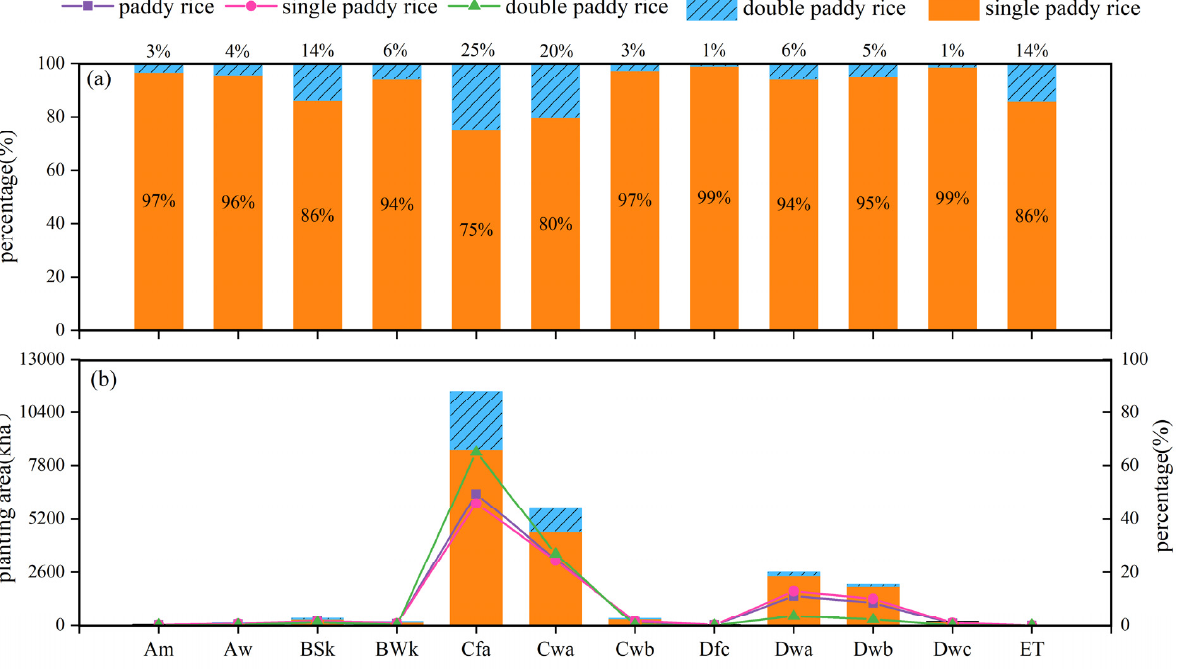
Figure 6. Spatial distribution of paddy rice planting area along with the climate zone: ( a ) percentage of single and double paddy rice in different climate zones; ( b ) paddy rice planting area in different climate zones. The bars represent the planting area of paddy rice and lines represent the percentage of paddy rice in different climate zones.